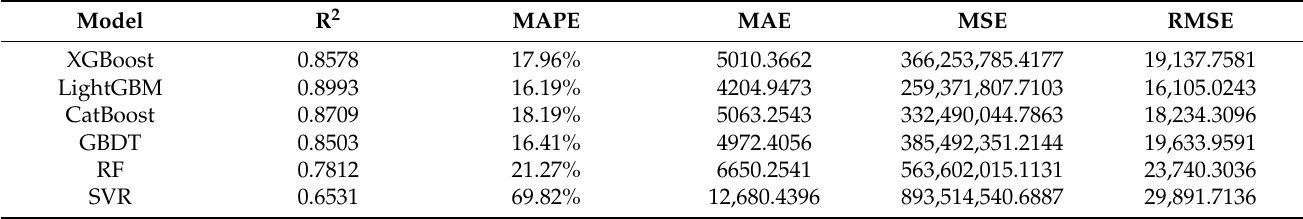
Table 6. Model prediction